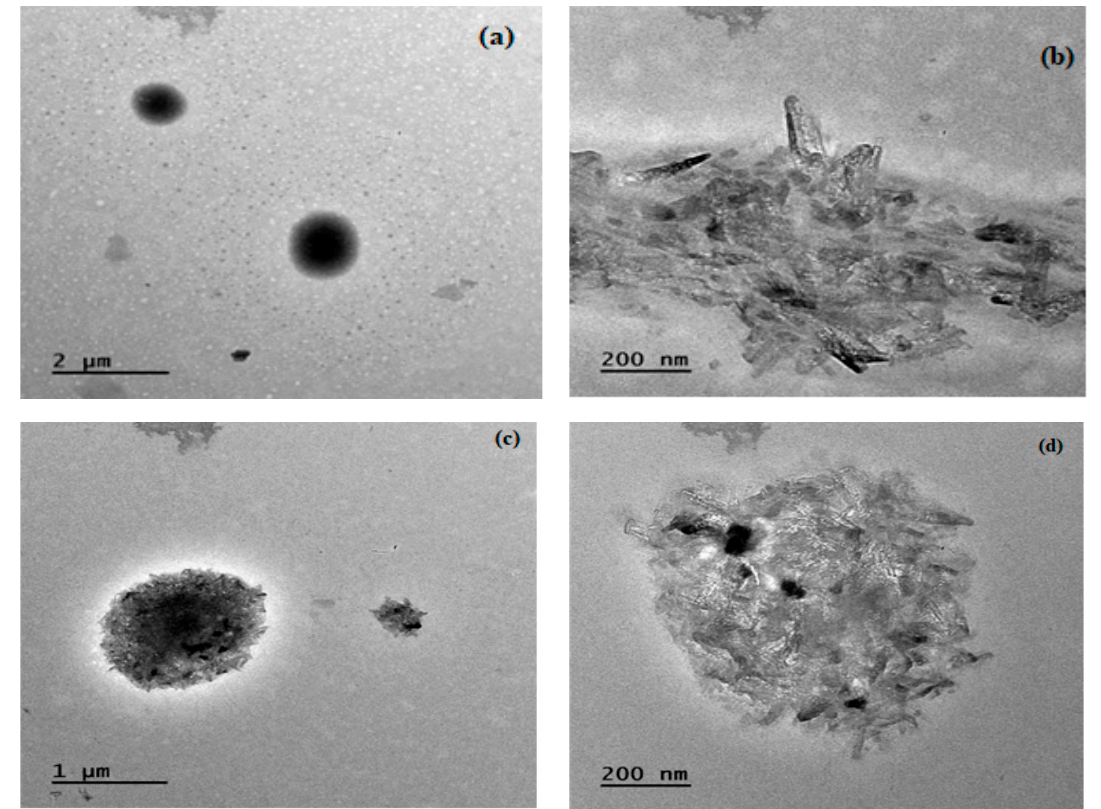
Figure 4. TEM images of biochar obtained from ( a , b ) non ‐ catalytic and ( c , d ) catalytic pyrolysis.